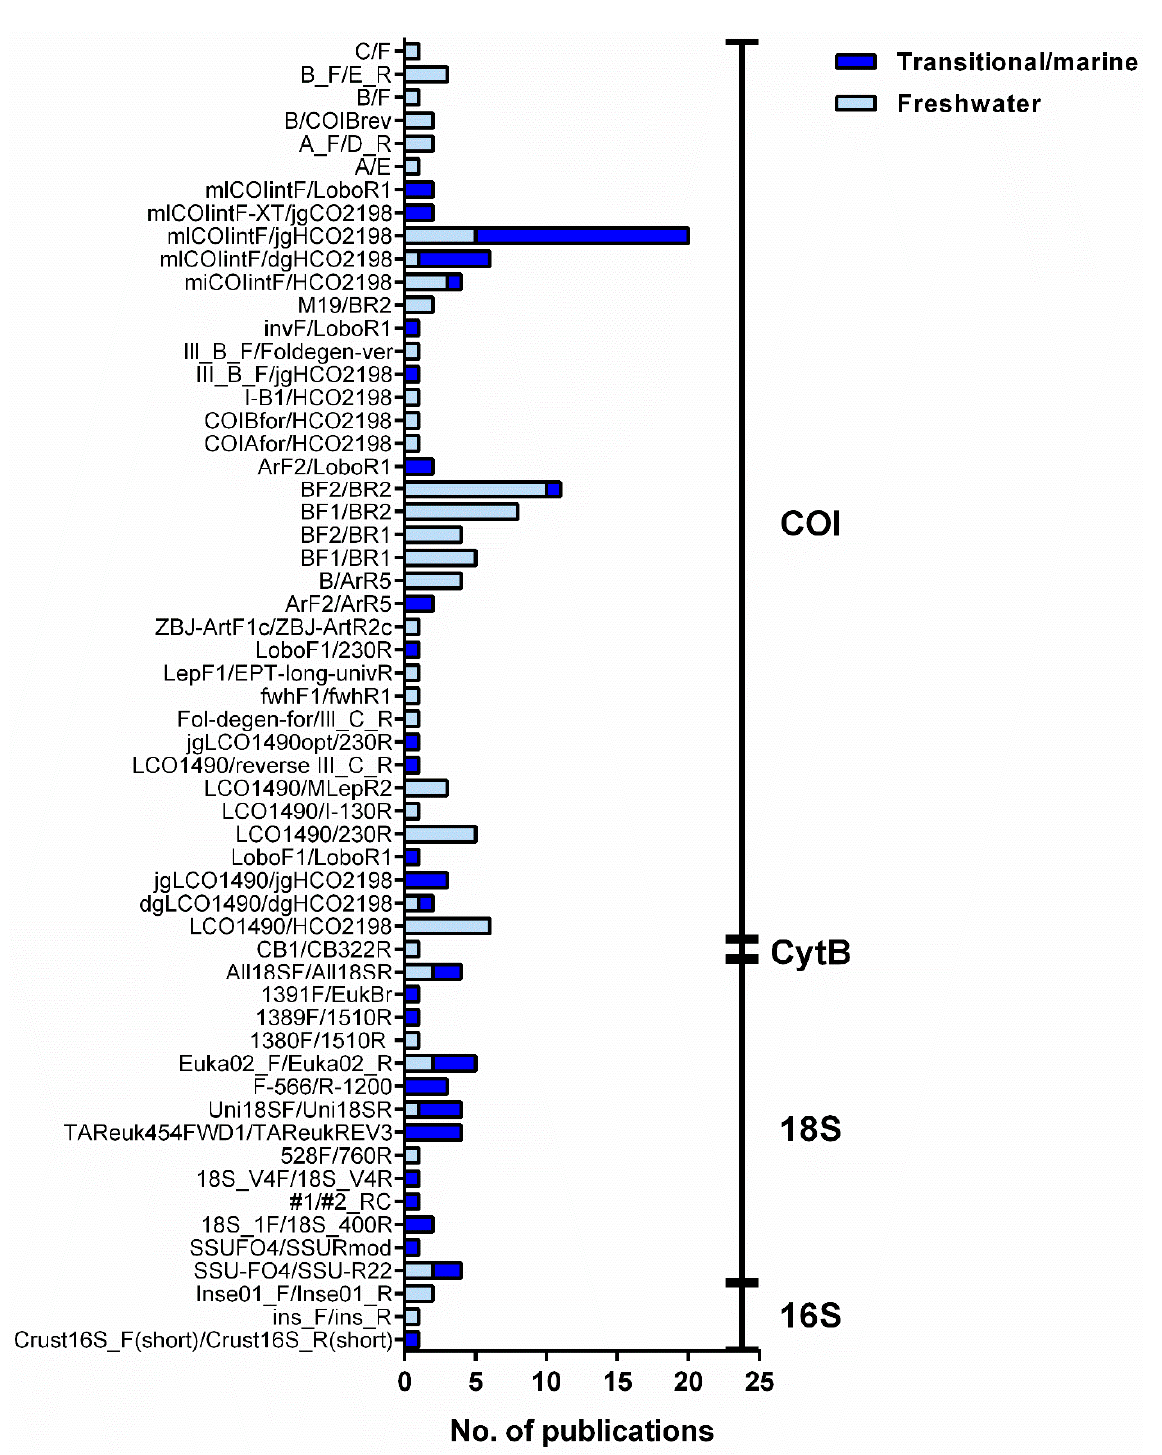
Figure 5. Marker loci and primer pairs used for assessing benthic macroinvertebrate diversity through metabarcoding in fresh and transitional/marine waters. Please see Supplementary Materials: Table S3, for more details of each primer pair (i.e., loci region and fragment length).